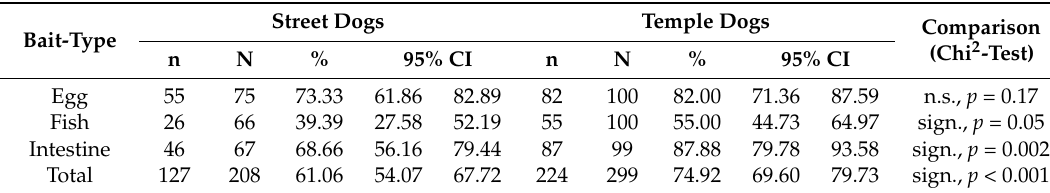
Table 4. Bait acceptance and gender of the dogs (n = number of baits accepted, N—number of baits offered, 95% CI—95% confidence interval, n.s.—not significant, sign.—significant).